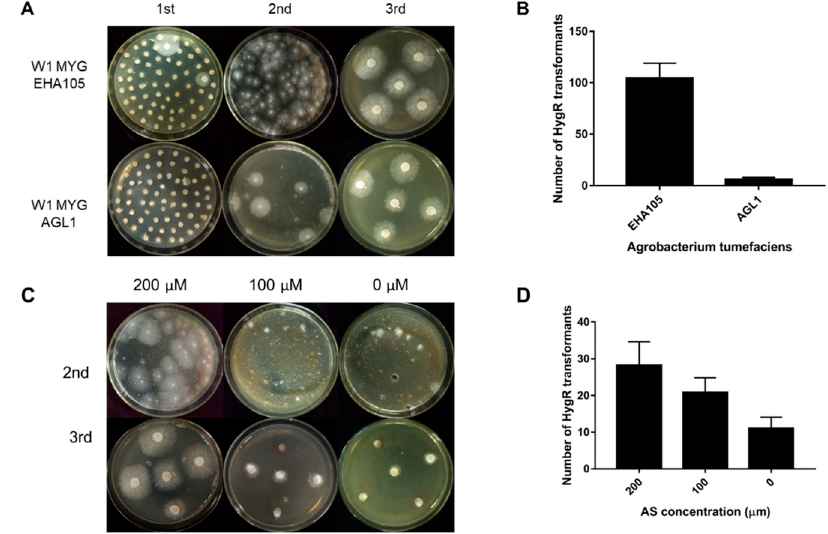
Figure 3. The transformation efficiency as affected by Agrobacterium tumefaciens strains and acetosyringone (AS) concentration. ( A ) The hygromycin; ( B ) resistance phenotype of transformation in the 1st, 2nd, and 3rd round of selection when using EHA105 and AGL1, respectively; ( C ) The hygromycin-B-resistant phenotype of transformation in the 2nd and 3rd round of selection when using AS at di ff erent concentrations (200 µ M, 100 µ M, and 0 µ M); ( D ) The number of hygromycin-B-resistant colonies per plate in the second selection. MYG: malt extract, yeast extract and glucose (MYG) agar medium.